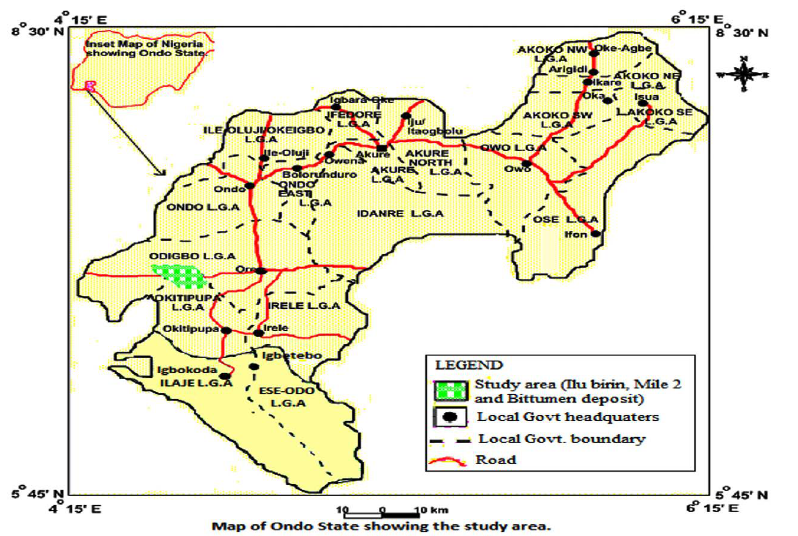
Fig. 1. Map showing location of sample